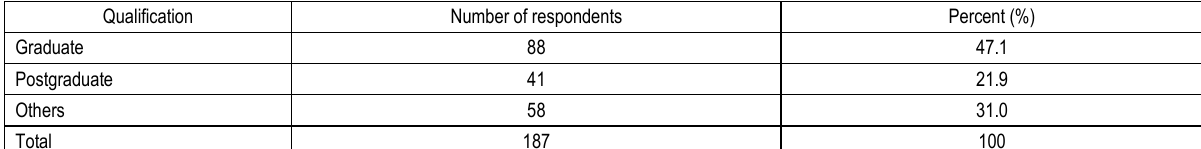
Table 1. Educational background or qualification of research respondents